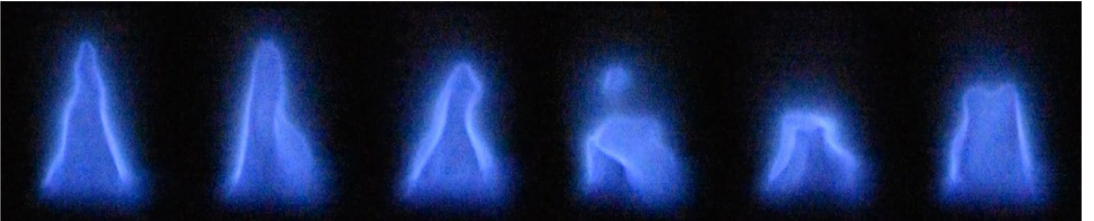
Figure 5. Still images from the video recordings demonstrating the wrinkling of the burner’s flame